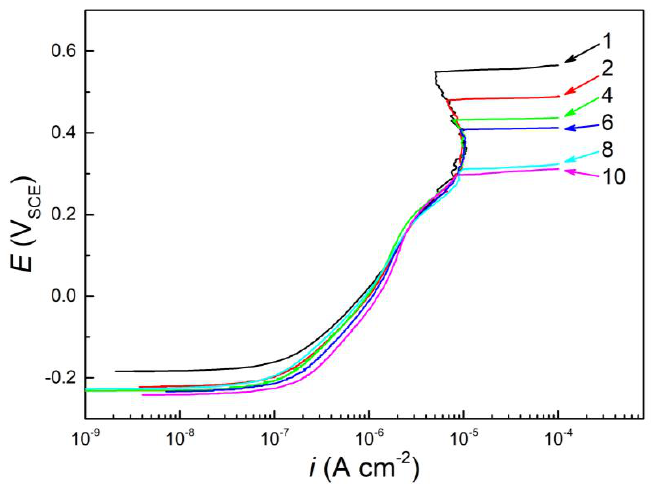
Figure 6. Polarization curves for specimens in the Ca 2+ and Mg 2+ -free solutions with different concentration ratios from 1 to 10 times.